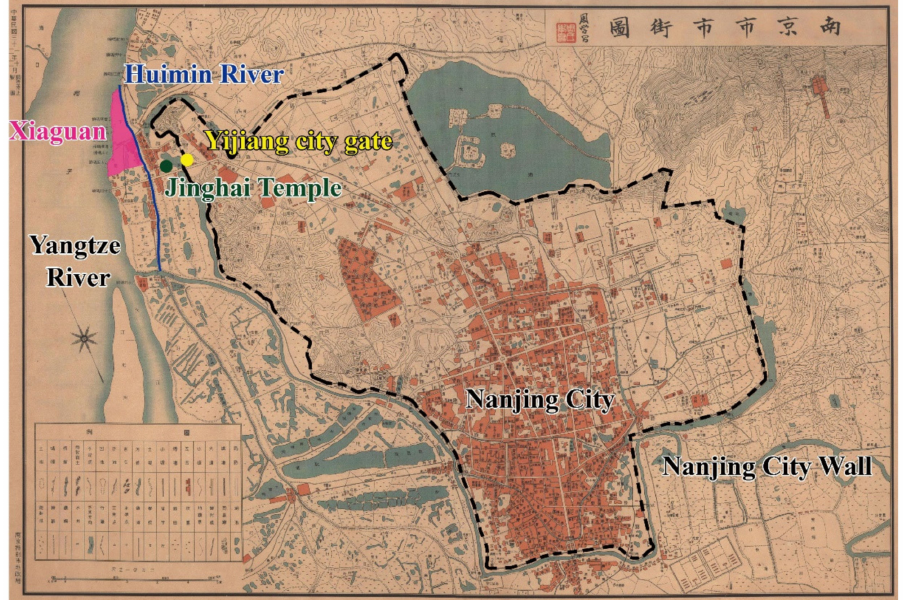
Figure 3. Location of Xiaguan (Map of Nanjing City in